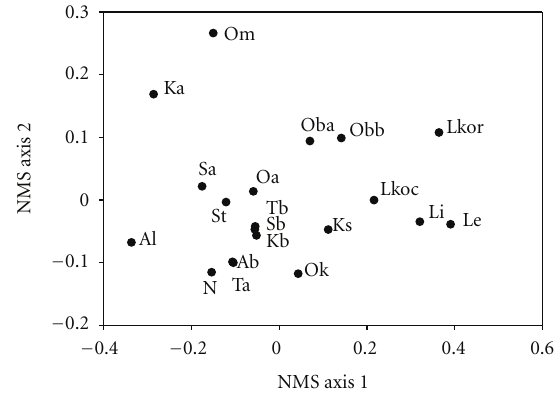
Figure 3: Two-dimensional NMS ordination of provincial (Diptera, Tipuloidea) crane fly assemblages (stress value 0.1105).